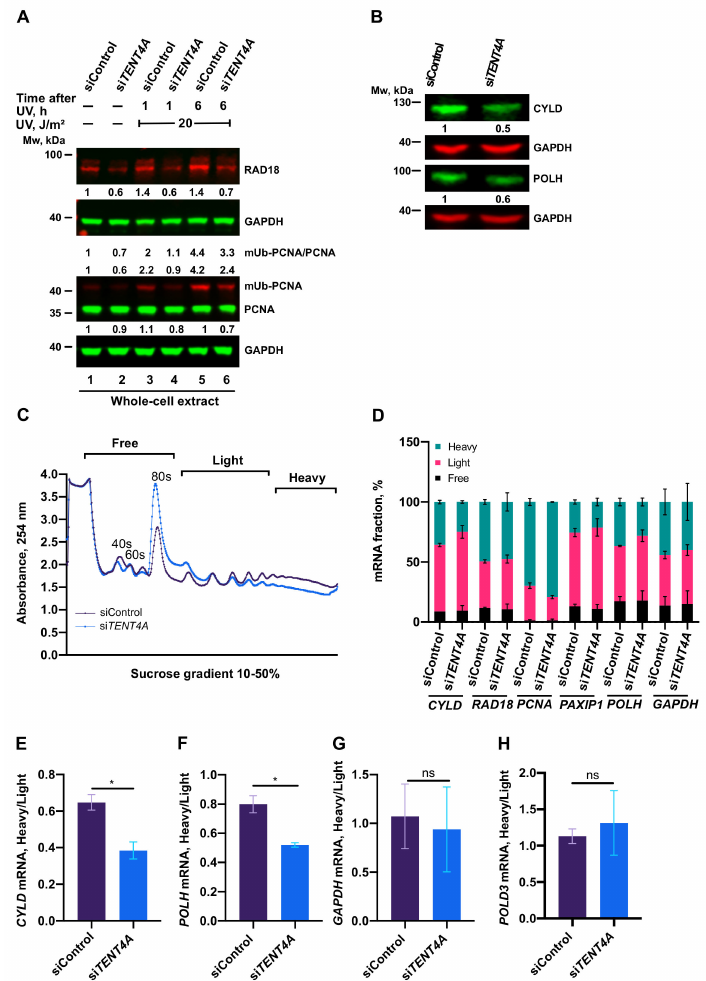
Figure 3. Effect of TENT4A on levels and translation of TLS proteins. ( A ) MCF-7 cells were transfected with TENT4A -targeted siRNA (si TENT4A ) or non-targeting control siRNA (siControl). At 65 h post- transfection, the cells were UV-irradiated at 20 J/m 2 and harvested 1 or 6 h post-irradiation. Whole- cell extracts were fractionated by SDS-PAGE followed by Western blot with indicated antibodies. Protein levels were normalized to GAPDH and presented each relative to its level in unirradiated siControl-treated cells. ( B ) Effect of cell treatment (72 h) with si TENT4A or siControl on the levels of the CYLD and POLH proteins in MCF-7 cells. Whole-cell extracts were fractionated by SDS-PAGE and analyzed by Western blot with indicated antibodies. Protein levels were normalized to GAPDH and presented each relative to its level in siControl-treated cells. ( C ) Polysome profile analysis in MCF-7 cells in which TENT4A expression was knocked down. Absorbance trace of polysome fractionation on a sucrose gradient. ( D ) qPCR analysis of mRNA levels of TLS-related genes in each fraction was expressed as a percentage of total levels summed over all fractions. The results are presented as the mean ± SEM of two independent experiments. ( E – G ) Fraction of polysome- associated mRNA of the genes CYLD , POLH and GAPDH , respectively. The values were taken from ( D ). ( H ) Fraction of polysome-associated mRNA of the POLD3 control gene. The results are presented as the mean ± SEM of two independent experiments. Statistical significance was determined